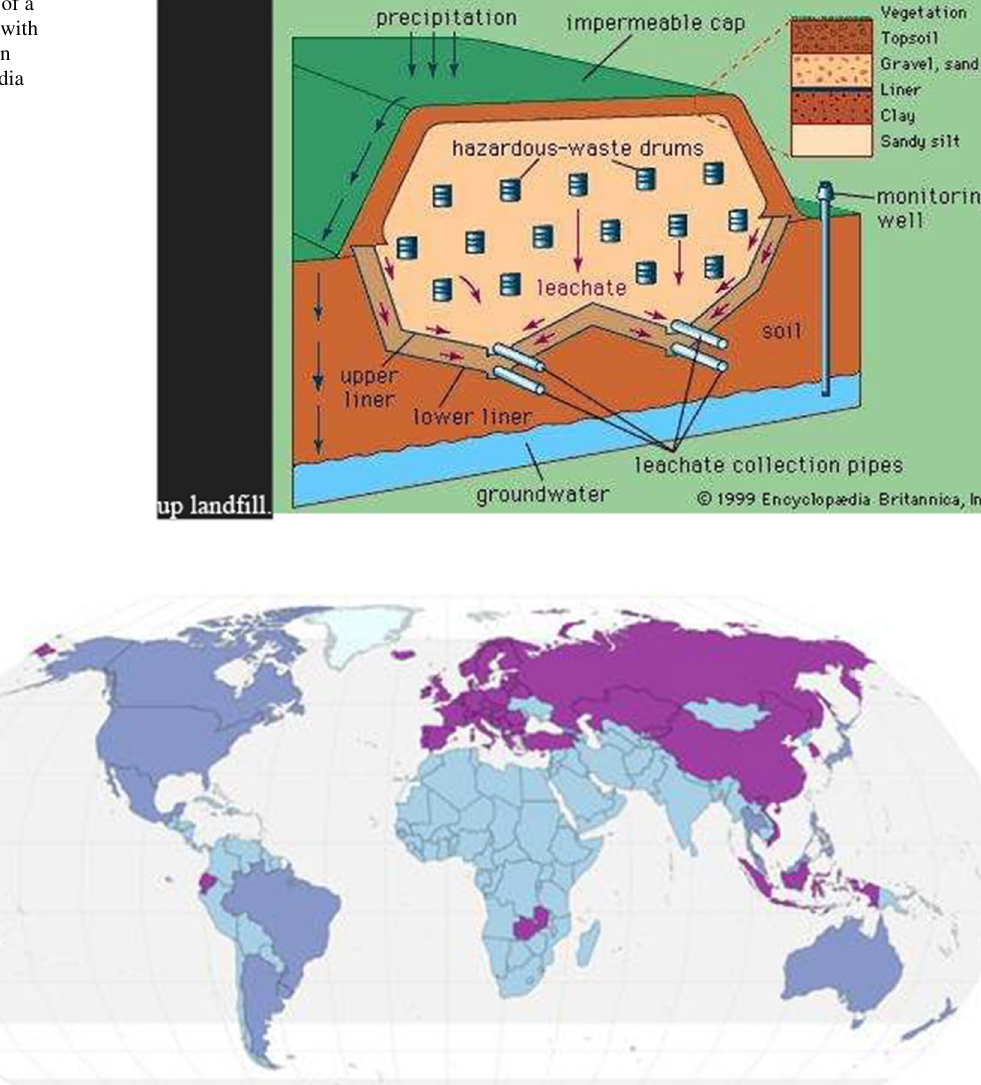
Fig. 9 Schematic diagram of a secure risks-waste landfill with a double leachate collection